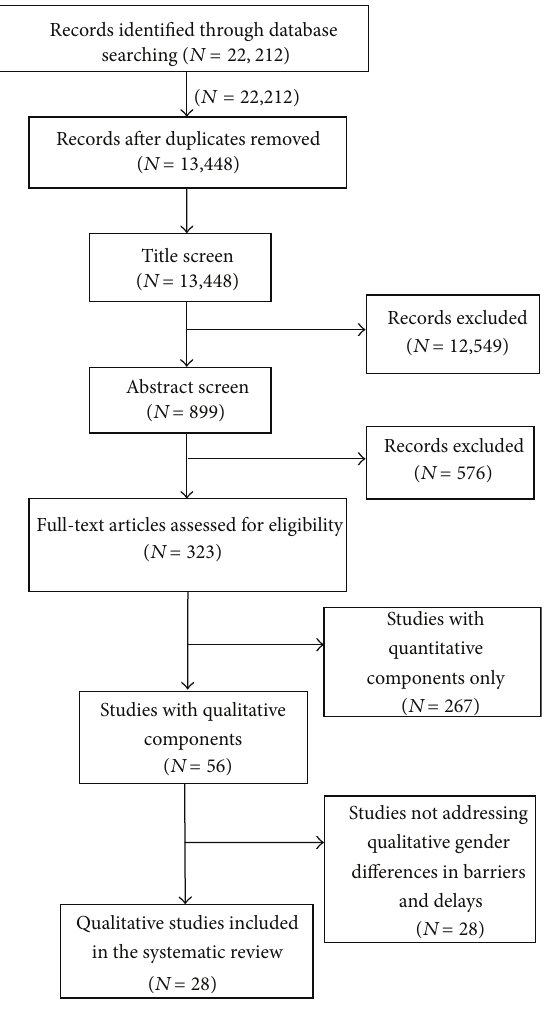
Figure 1: Study selection